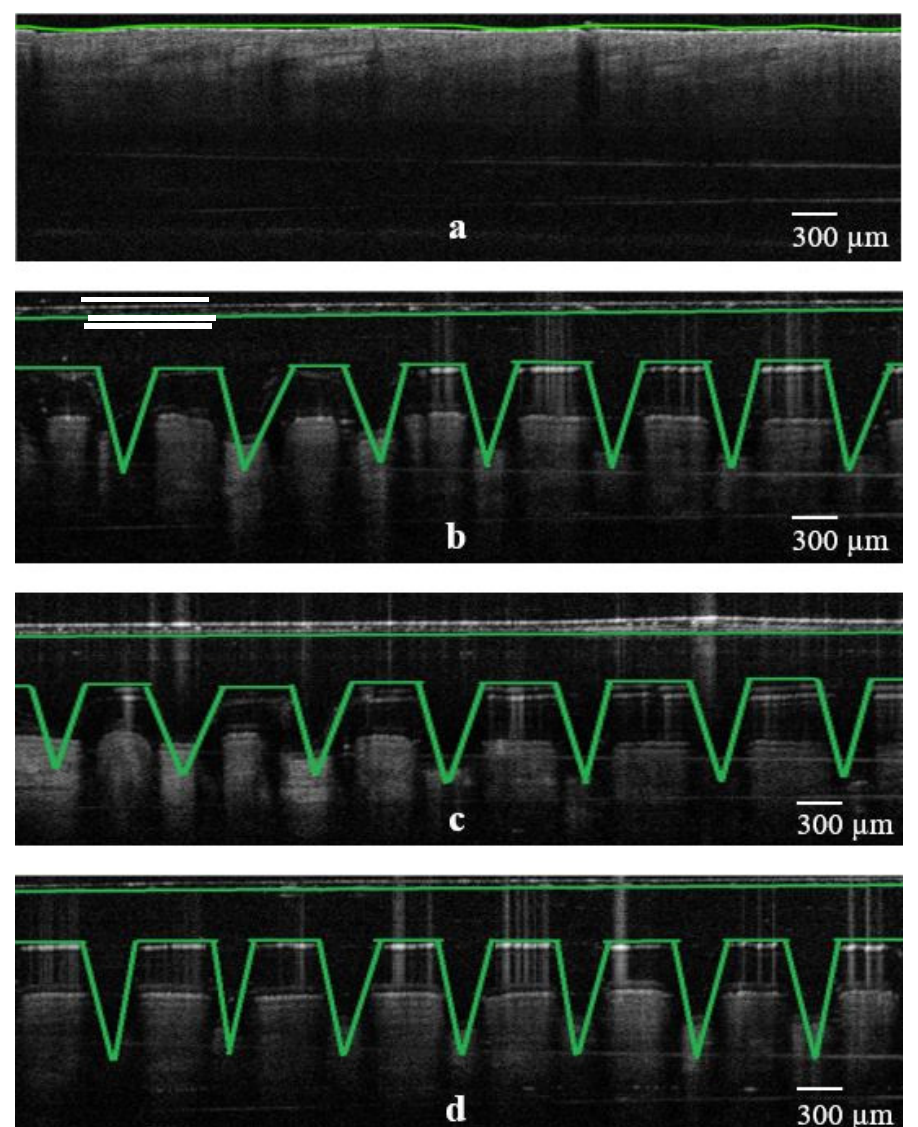
Figure 7. False color 2D still images of 3D-printed MNs (3-sided pyramid design; 3P1, 3P2 and 3P3) showing the real-time penetration into the mouse skin using OCT. ( a ) Skin sample as control before experiment; ( b ) insertion of 3P1 design; ( c ) insertion of 3P2 design; ( d ) insertion of 3P3 design, respectively (scale bar 300 μ m).